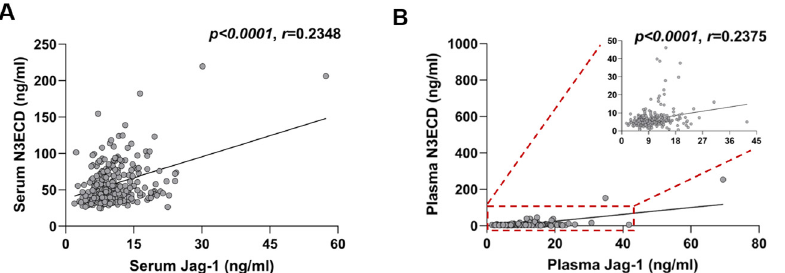
Figure 1. NOTCH3 extracellular domain (N3ECD) levels in healthy adults. N3ECD levels were measured in serum and plasma from healthy adults by ELISA ( n = 279) ( A ) and a correlation be- tween serum and plasma N3ECD levels was analyzed ( B ). Jagged-1 levels were measured in serum and plasma ( C ) and their correlation was assessed ( D ). Each symbol represents a value from a single subject; midline represents the mean; and error bars represent the standard error. The resulting Spearman’s correlation coefficient ( r ) and corresponding p value are reported.